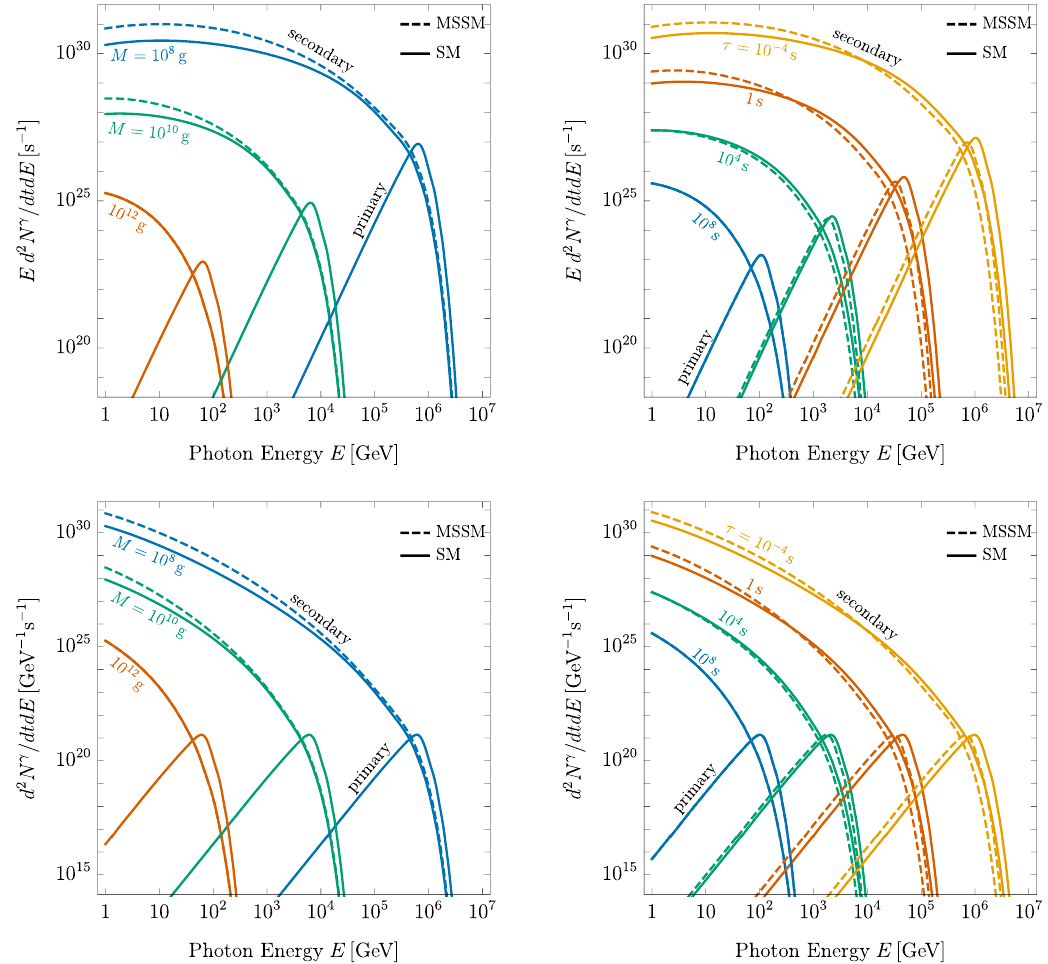
Figure 6 . Primary and secondary photon spectra for the SM and MSSM for M = 10 12 , 10 10 , 10 8 g (top left) and τ = 10 8 , 10 4 , 10 0 , 10 − 4 s (top right). In the lower panels we show the same but without multiplying the flux, d 2 N γ /dtdE , by the energy, E